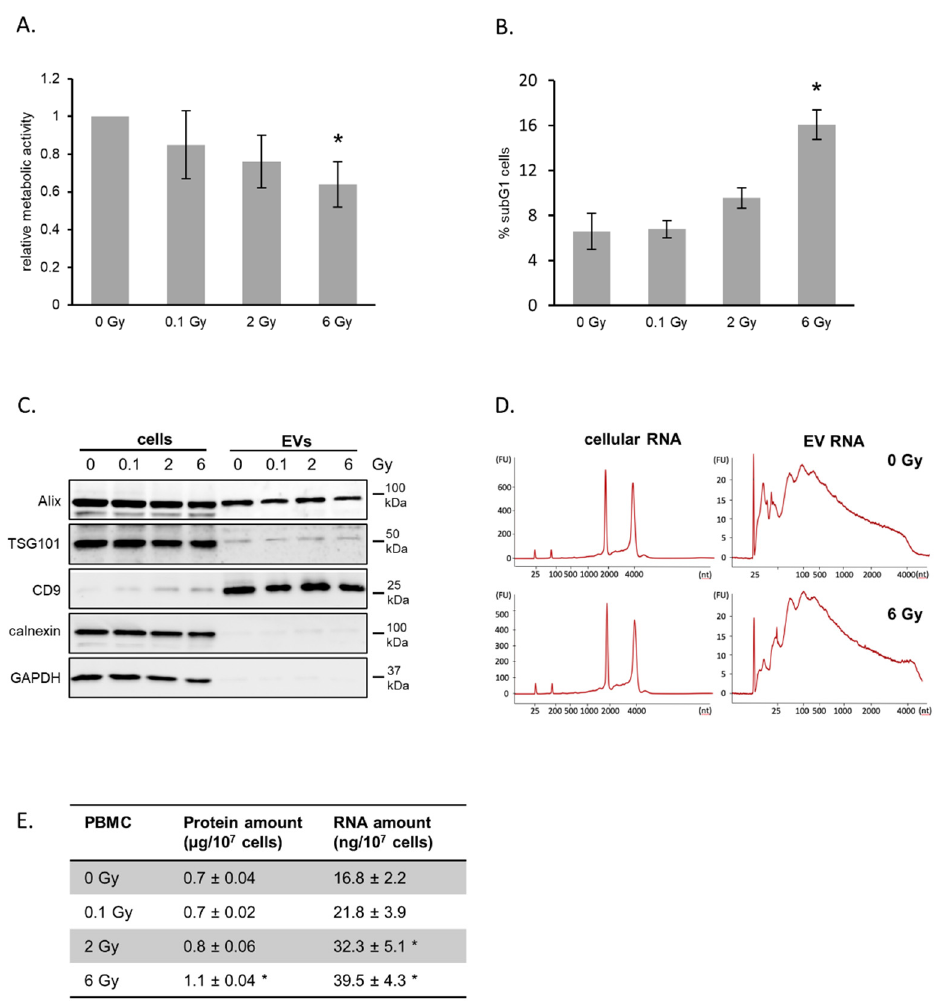
Figure 1. Irradiation of peripheral blood mononuclear cells (PBMCs) and release of extracellular vesicles (EVs). ( A ) Metabolic activity of PBMCs after irradiation. Whole blood was irradiated and PBMCs were isolated and cultivated for 72 h. Mean values from three biological replicates ± SD are shown. ( B ) Quantification of cells in subG1 phase 72 h after irradiation with the indicated doses. Mean values from three biological replicates ± SD are shown. ( C ) Representative Western blot of exosome marker proteins ALIX, TSG101 and CD9 as well as cytosolic markers GAPDH and Calnexin for PBMCs and vesicle lysates 72 h after irradiation. ( D ) Size distribution of total RNA derived from PBMC and PBMC-released EVs determined by Bioanalyzer technology. ( E ) Total protein and RNA yields isolated from EVs released from PBMCs 72 h after irradiation. Proteins were measured by BCA assay and total RNA was quantified by measuring the absorption at 260 nm. Mean values from three biological replicates ± SD is shown. * p ≤ 0.05 (calculated by two-sided Student’s t-test).